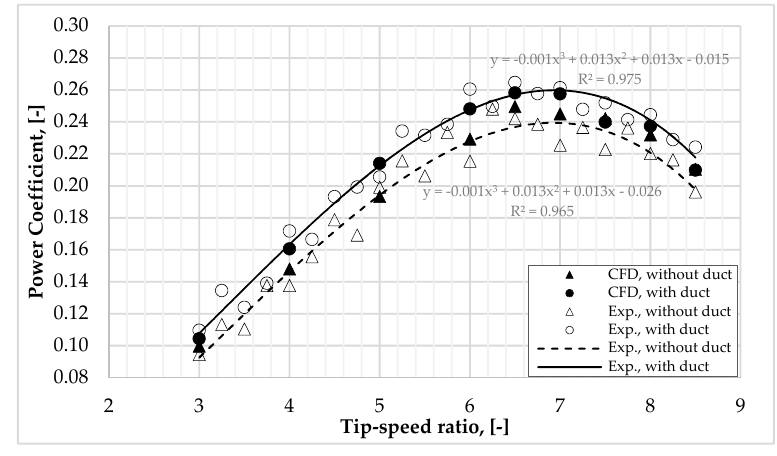
Figure 5. Comparison of the experimental study and CFD analysis results performed at 6 m/s air velocity and 7 tip-speed ratio.